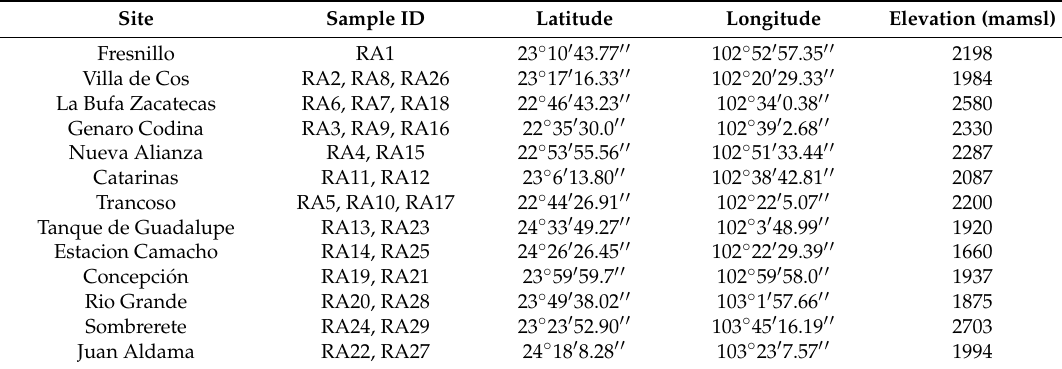
Table 1. Rainfall sampling locations (elevation values are in meters above mean sea